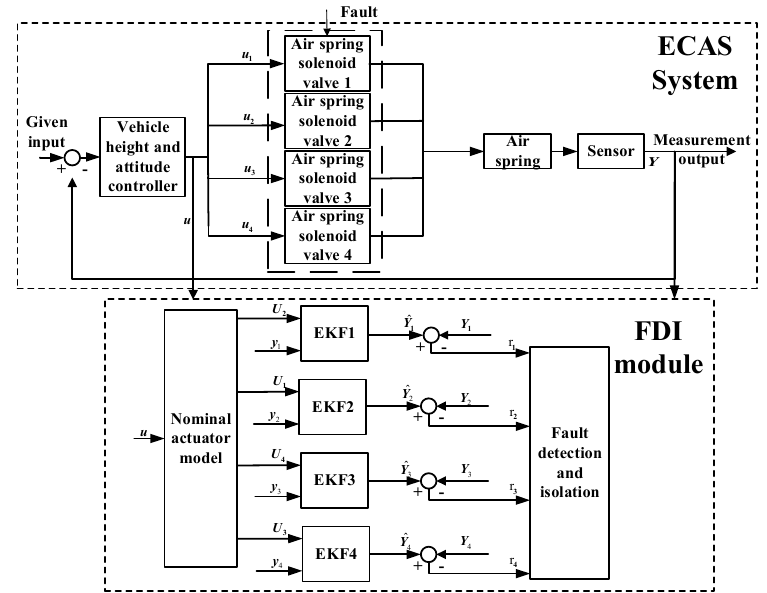
Figure 4. Actuator fault detection & isolation strategy of the vehicle ECAS system. According to Equation (5) and the selected state variables, measurement output, and control input, write the corresponding system and measurement equations, respectively.